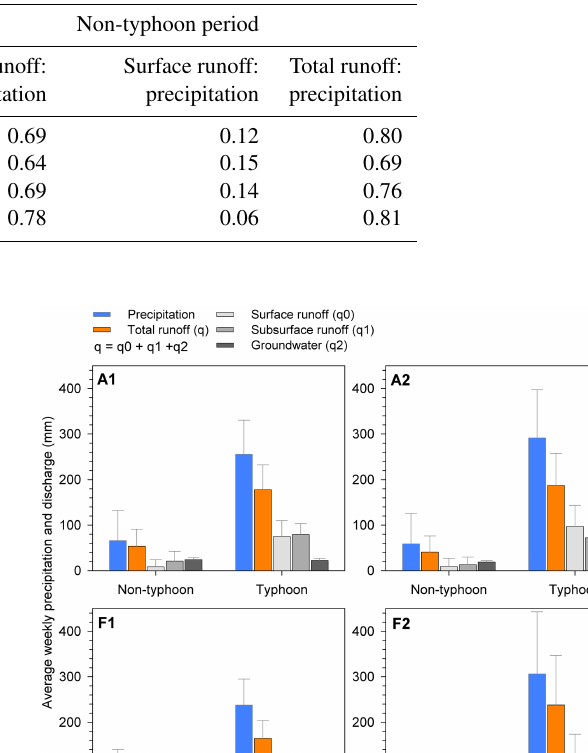
Figure 3. The average weekly precipitation and estimated stream- flow composition during typhoon and non-typhoon period among the four watersheds. The grey bars indicate 1 standard